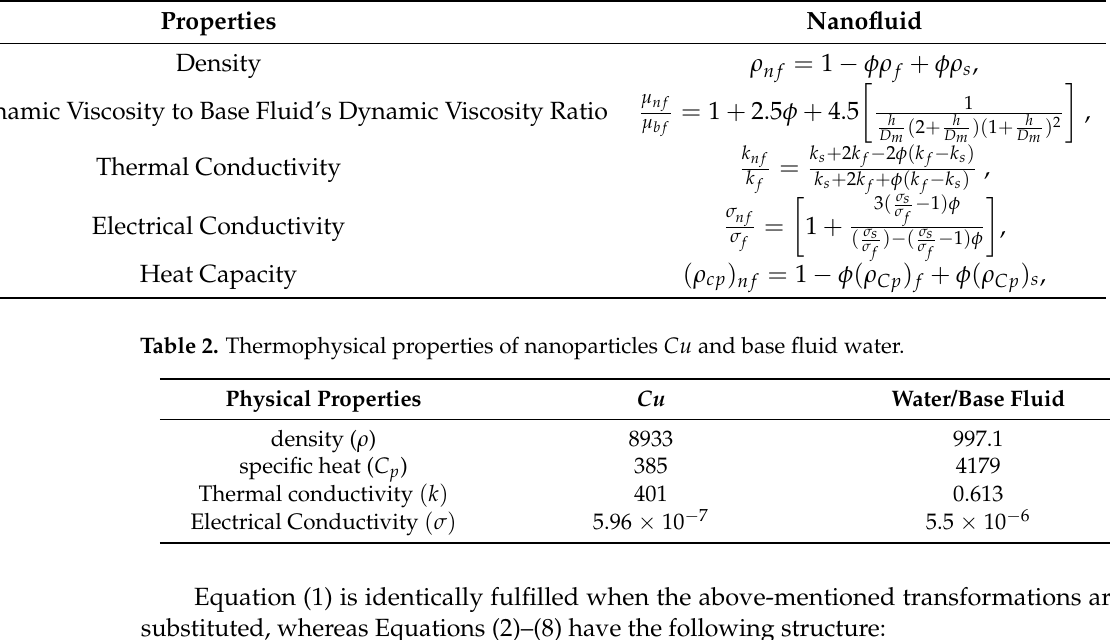
Table 1. Thermophysical properties of nanofluids are represented by mathematical relationships [51].